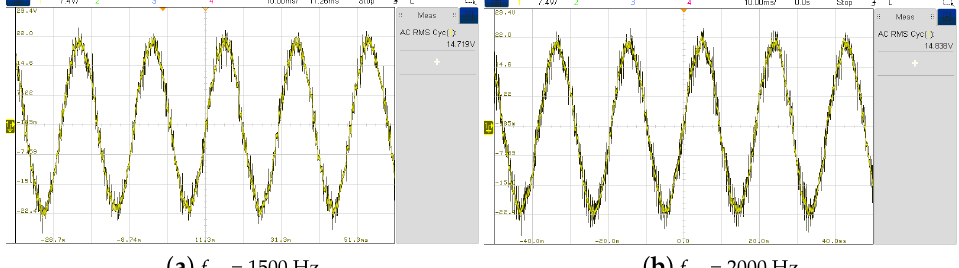
Figure 20. Phase Voltage